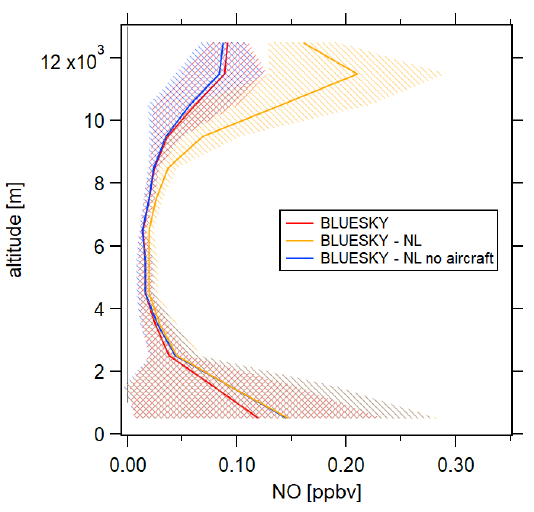
Figure 4. NO vertical profiles for BLUESKY (red), for the BLUESKY no-lockdown scenario (yellow) and for the BLUESKY no-lockdown scenario without aircraft emissions (blue) (model data). Upper-tropospheric NO reductions observed for BLUESKY can be attributed to reduced air traffic during the COVID-19 lock-